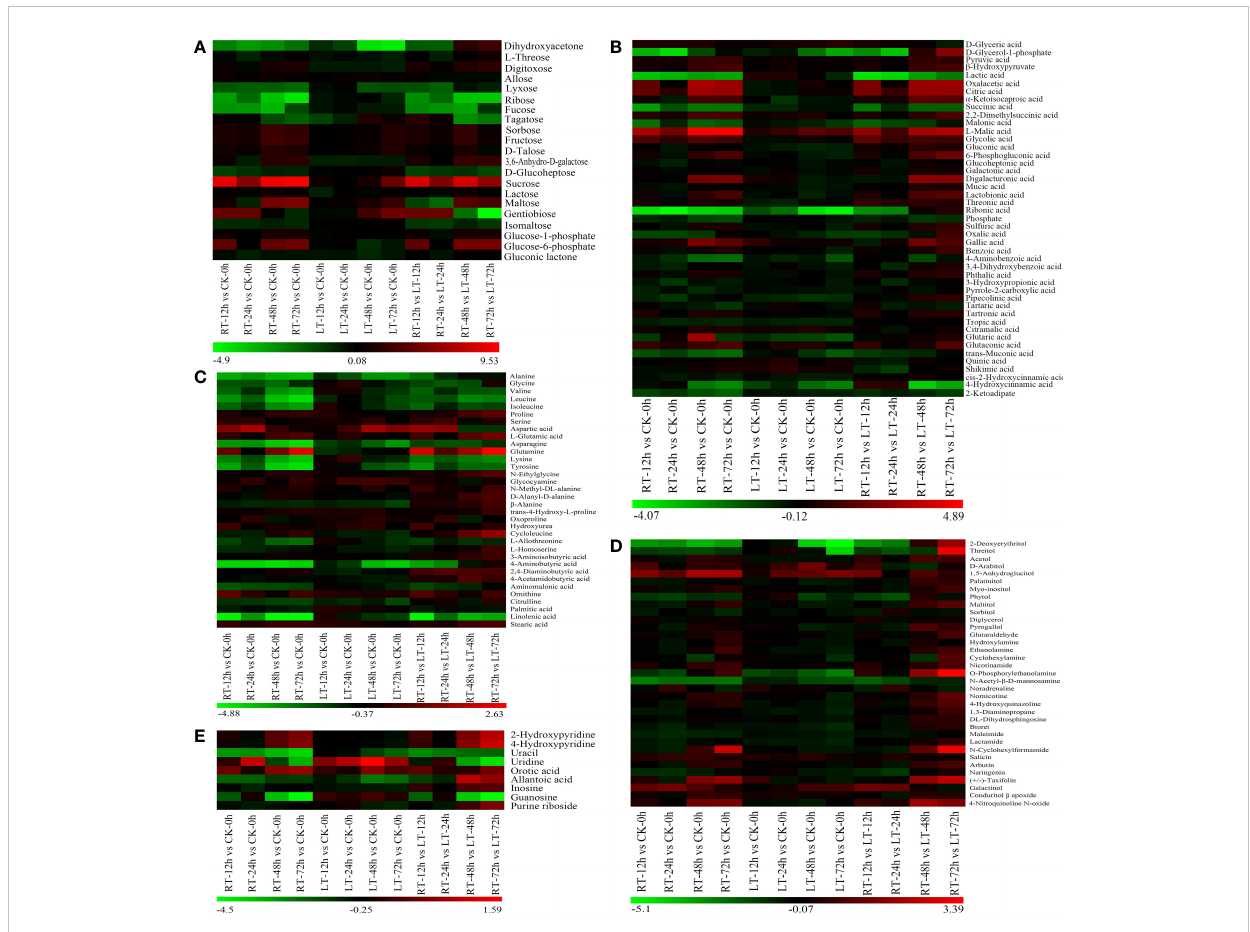
FIGURE 5 Hierarchical cluster analysis of changes in various carbohydrates (A) , organic acids (B) , amino acids (C) , alcohol, aldehyde, amine, and their derivatives (D) , and pyridine, pyrimidine and purine (E) in toon buds during storage. Red indicates high abundance. The metabolites with low relative abundance are shown in green. (The color key scale is at the bottom of the